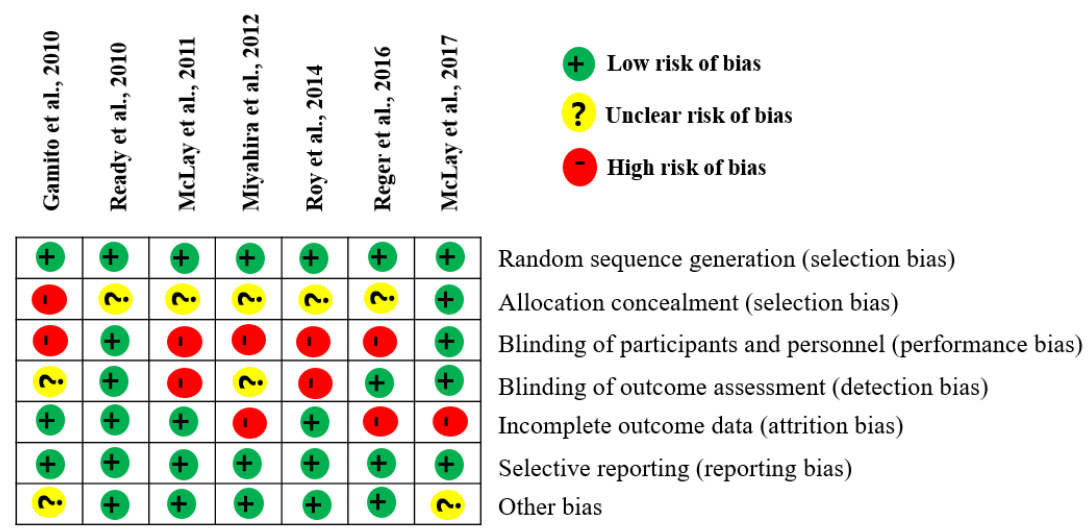
Figure 2. Summary of the risk of bias of the included studies in this meta-analysis. Green indicates a low risk of bias, yellow indicates unclear bias, and red indicates a high bias risk. Gamito et al. (2013) [13]; McLay et al. (2011) [15]; Miyahira et al. (2012) [16]; Ready et al. (2010) [17]; McLay et al. (2017) [19]; Reger et al. (2016) [20]; Roy et al. (2014) [27].